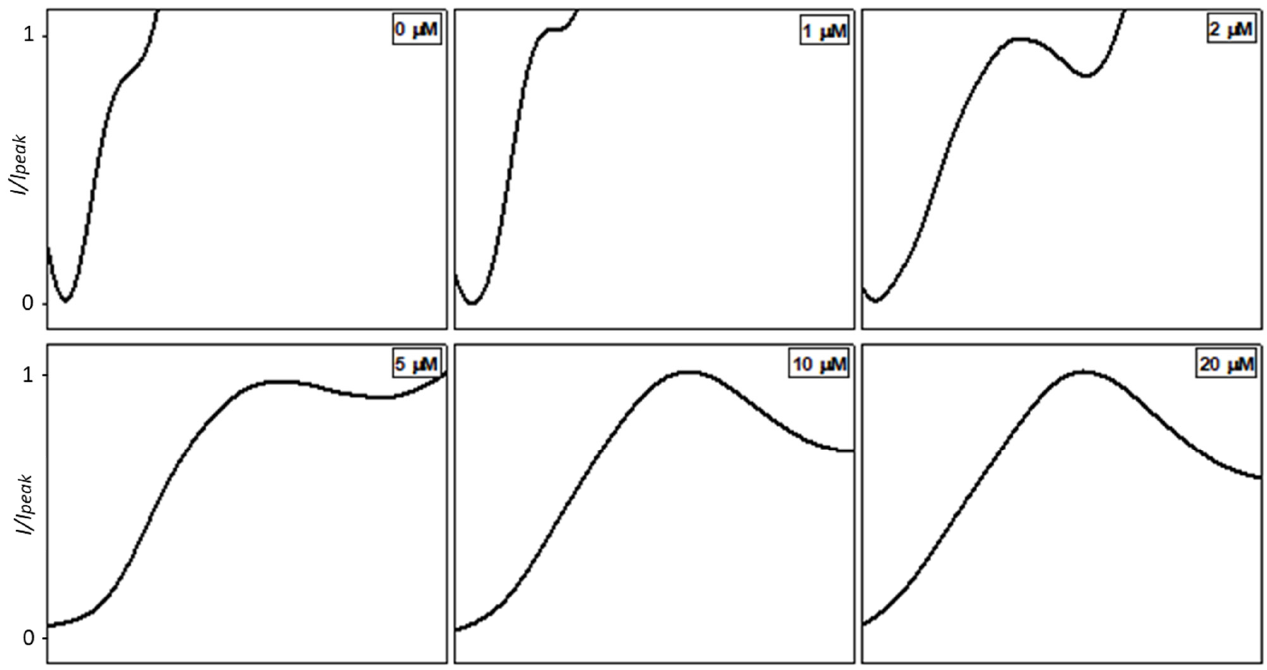
Figure 3. Comparison between normalized peak shapes at different copper ion concentrations in physiological conditions (pH 7.4).